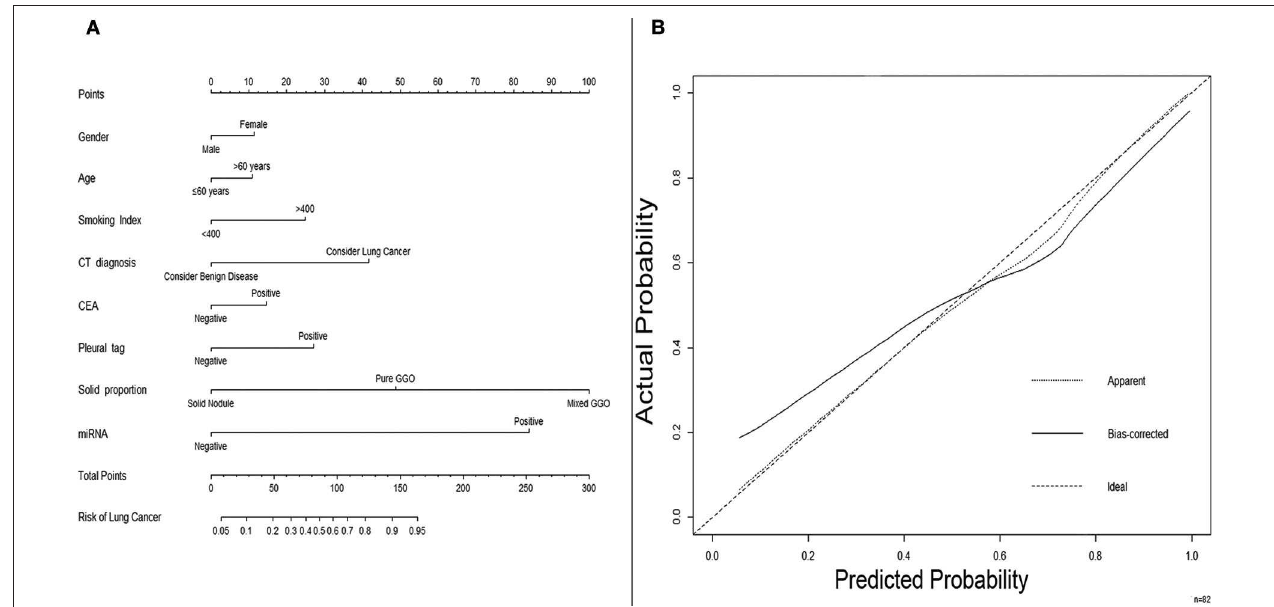
FIGURE 5 | A nomogram predicting the risk of non-small cell lung cancer. (A) A nomogram predicting the probability of non-small cell lung cancer. The value of each factor is given a score on the point scale axis. The total score can be calculated by adding every single score and projecting the total score to the total point scale so that clinicians can estimate the probability of NSCLC. (B) Calibration curves for the nomogram. The x -axis represents the probability predicted by the nomogram, and the y -axis represents the actual probability of NSCLC. NSCLC, non-small cell lung cancer.